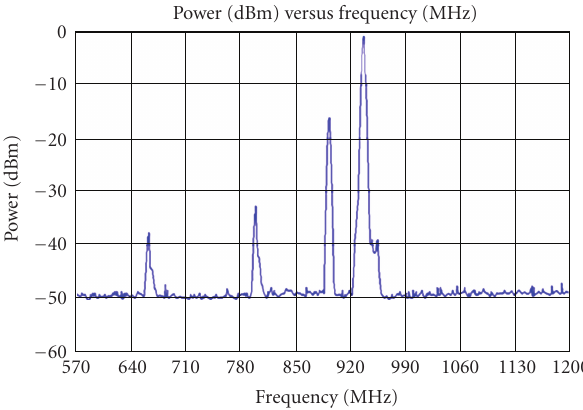
Figure 3: RF signal spectrum at a city location (948–950MHz).